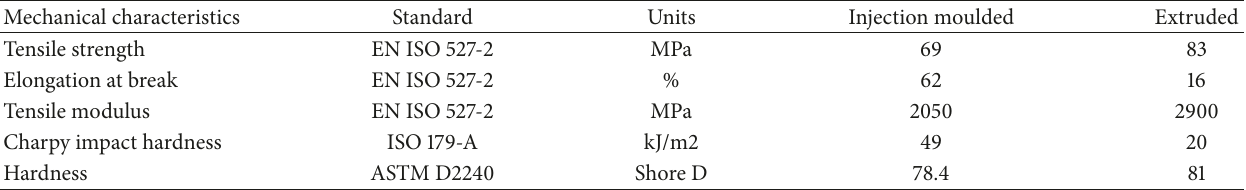
Table 1: Mechanical properties of injection moulded and extruded material